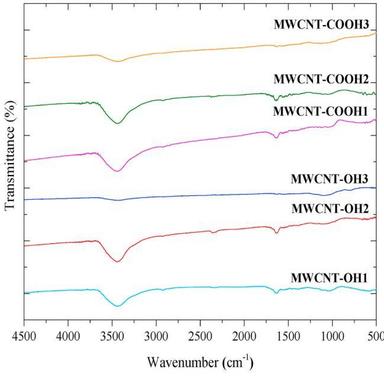
FTIR vibrational spectra of the original (a) and modified (b) MWCNTs.